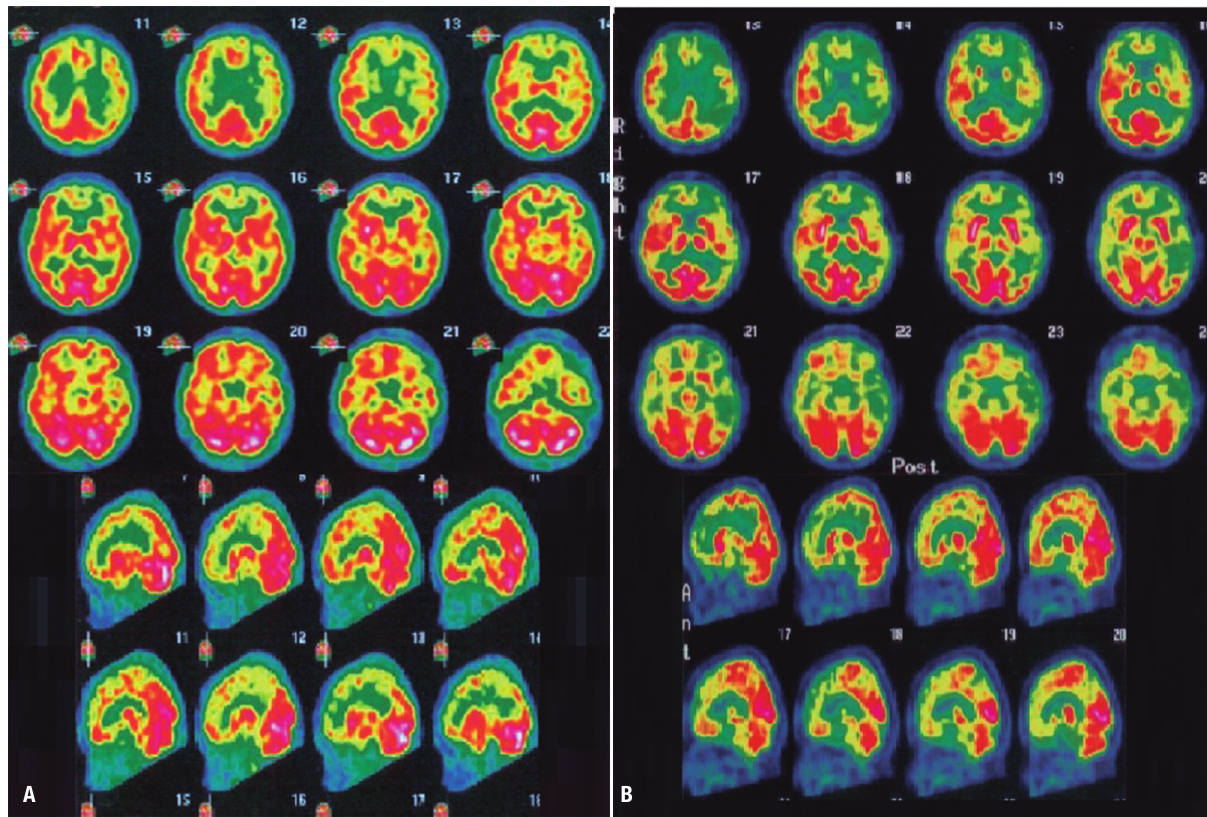
Figure 2. Brain scintigraphy (SPECT) from patient TA, 48 year-old woman. [A] Brain SPECT after approximately one year since symptoms onset (May/2010): moderate hypoperfusion in medial and dorsolateral prefrontal cortex, with left predominance; very mild hypoperfusion in the left parietal cortex; no hypoperfusion in medial temporal regions. [B] Brain SPECT approximately two years after symptoms onset (March/2011): severe hypoperfusion in prefrontal cortex (with left predominance); severe hypoperfusion in the left parieto-temporal cortex; mild hypoperfusion in the right parieto-temporal cortex; very mild hypoperfusion in the medial temporal